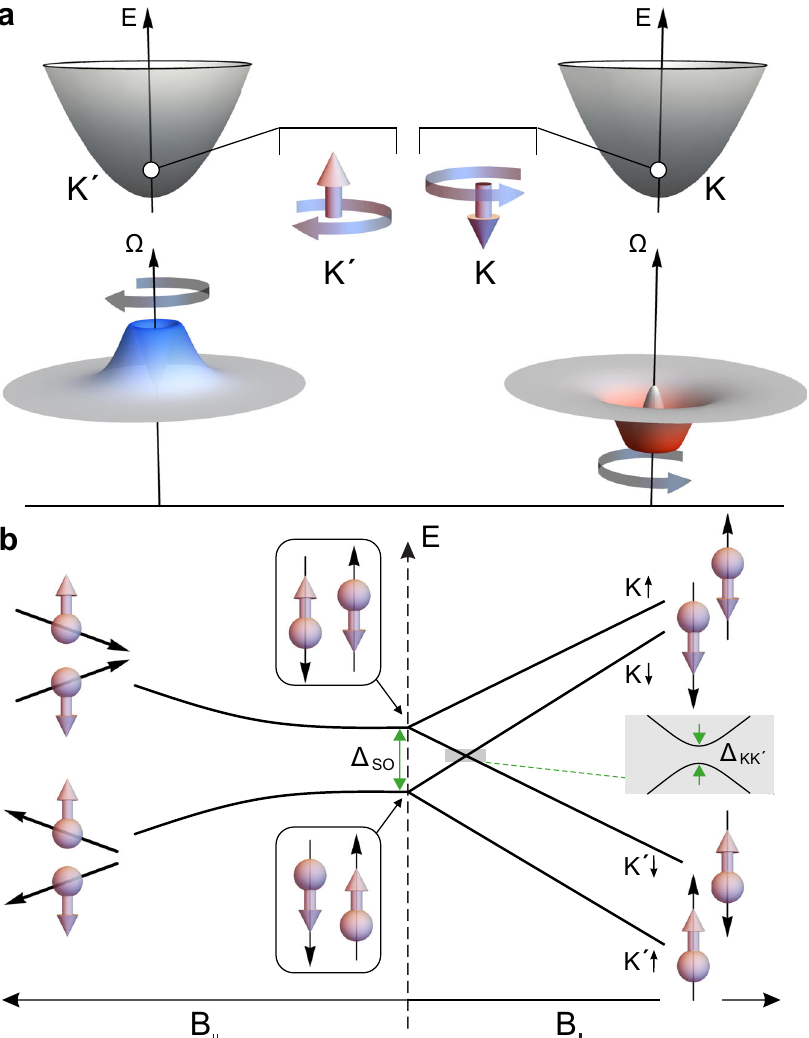
Fig. 1 Band structure and single particle spectrum of a BLG quantum dot. a Low energy band schematic of BLG at the K and K 0 points. BLG exhibits a non- trivial Berry curvature Ω that leads to an effective out-of-plane magnetic moment with opposite sign at K and K 0 . b Energy dispersion of single-particle states in BLG QDs as a function of in-plane ( B ∥ , left) and out-of-plane ( B ⊥ , right) applied magnetic fi elds with respect to the BLG plane. The SO gap, Δ SO , lifts the fourfold degeneracy and polarizes the spins out-of-plane for zero magnetic fi eld and a potential K - K 0 state mixing (described by Δ anticrossing of the K # and K 0 #